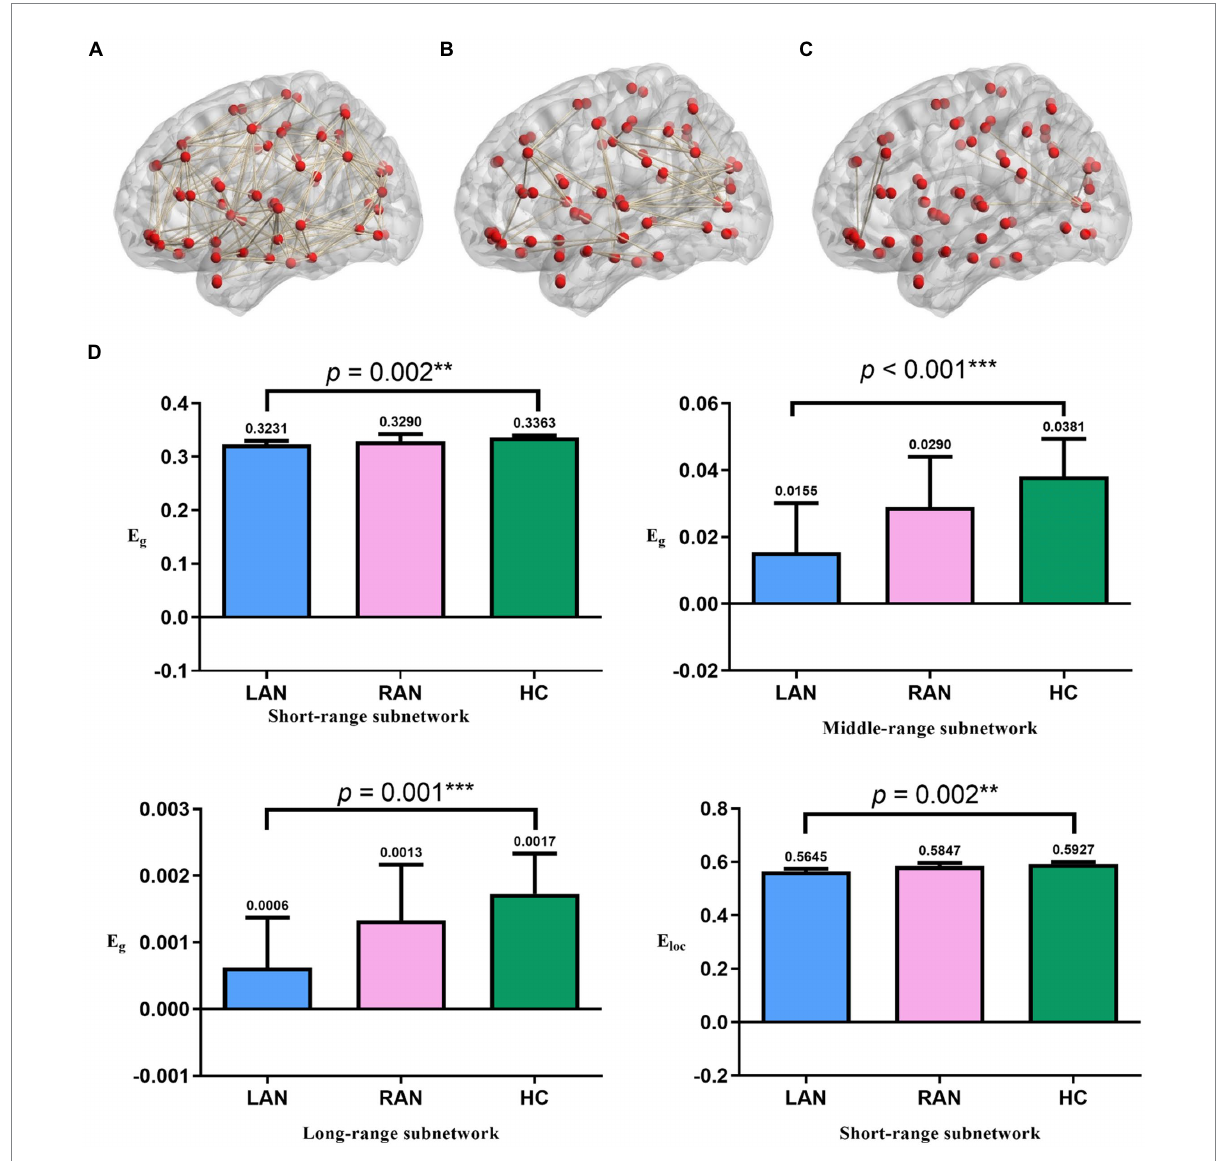
FIGURE 6 The results of subnetworks. (A) Short-range subnetwork of one subject (B) middle-range subnetwork of the same subject. (C) long-range subnetwork of the same subject. (D) Comparison of global metrics (E g and E loc ) in the three groups. The global metrics of the three subnetworks in AN patients significantly decreased. The numbers above the error bars represent median values. Error bars represent median ± 95%CI. * p < 0.05, ** p ≤ 0.01, *** p ≤ 0.001; LAN: left acoustic neuroma; RAN: right acoustic neuroma; HC: health